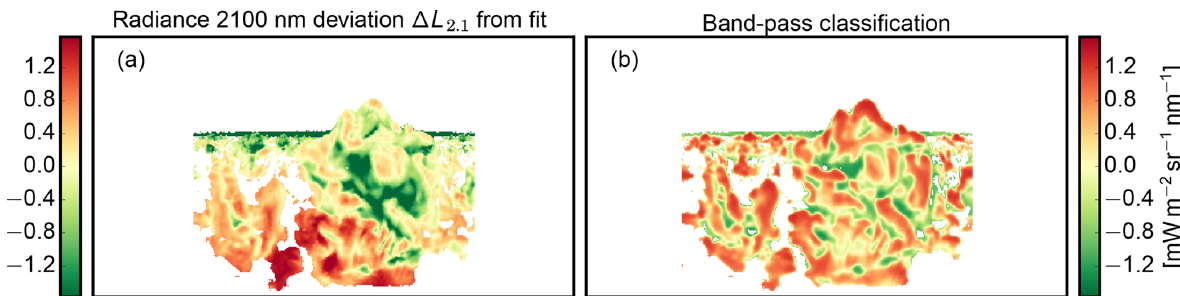
Figure 15. (a) Deviation (cid:49)L 2 . 10 from the fit in the two-wavelength diagram in Fig. 14a used as a reference for the (b) gradient classifier g class , which puts the pixel radiance into context with surrounding pixels.